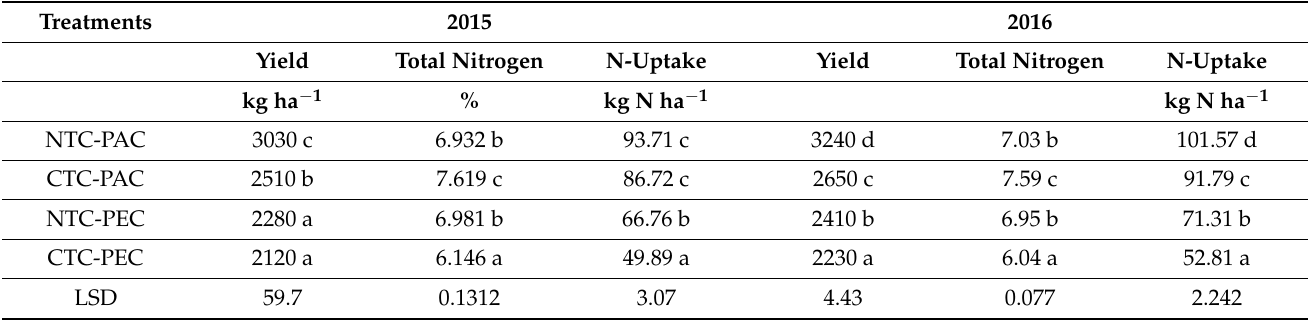
Table 9. N uptake when intercropping Triticosecale - Pisumsativum cultivation (kg N ha − 1